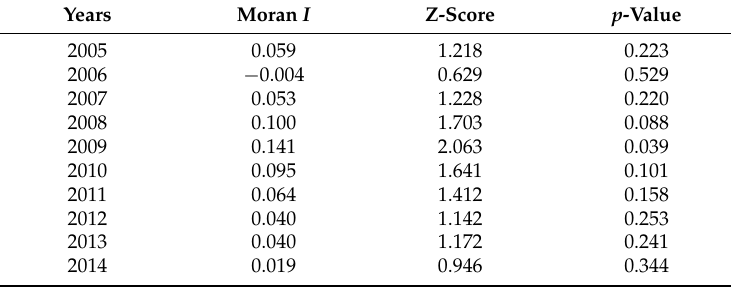
Table 3. The results of the global spatial autocorrelation test of scarlet fever cases in Beijing, 2005–2014.